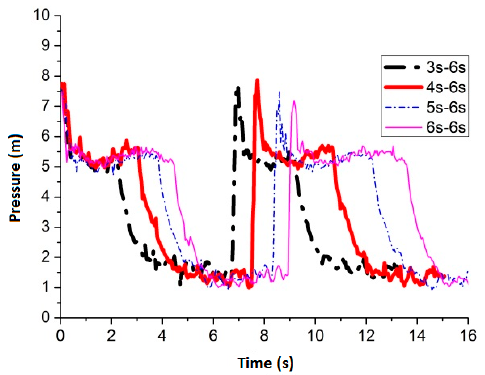
Figure 22. The four best pressure values when the slot nozzle is set in the middle of the pipe.